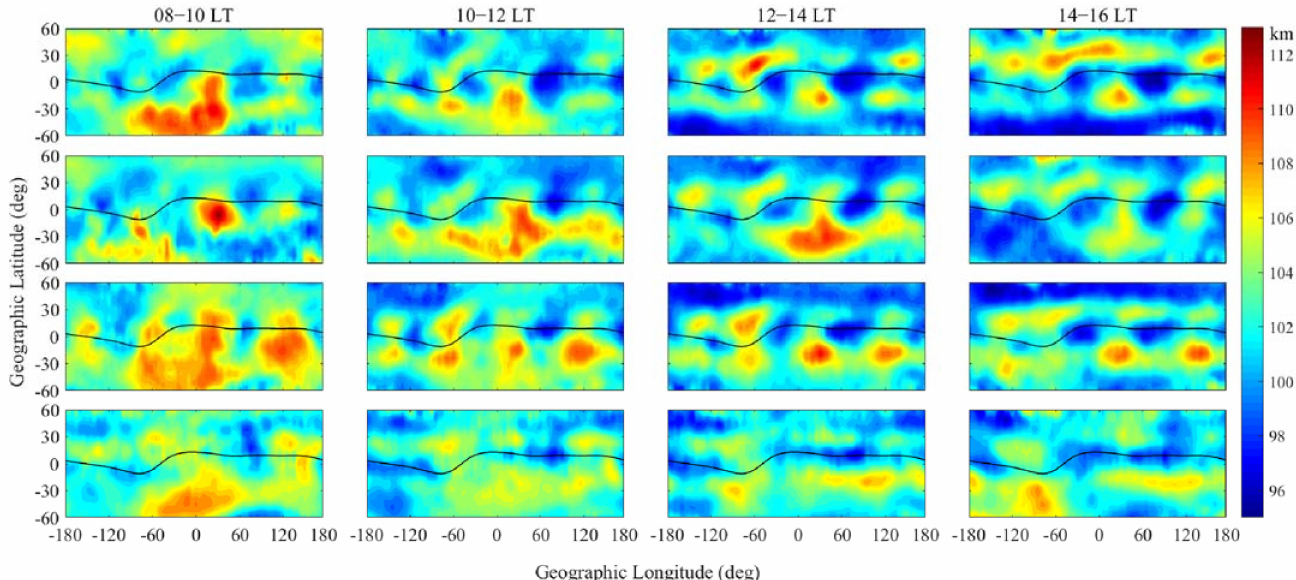
Figure 2. Global distributions of the Es height in the LT fixed reference for the March equinox ( the first row ), June solstice ( the second row ), September equinox ( the third row ), and December solstice ( the fourth row ).